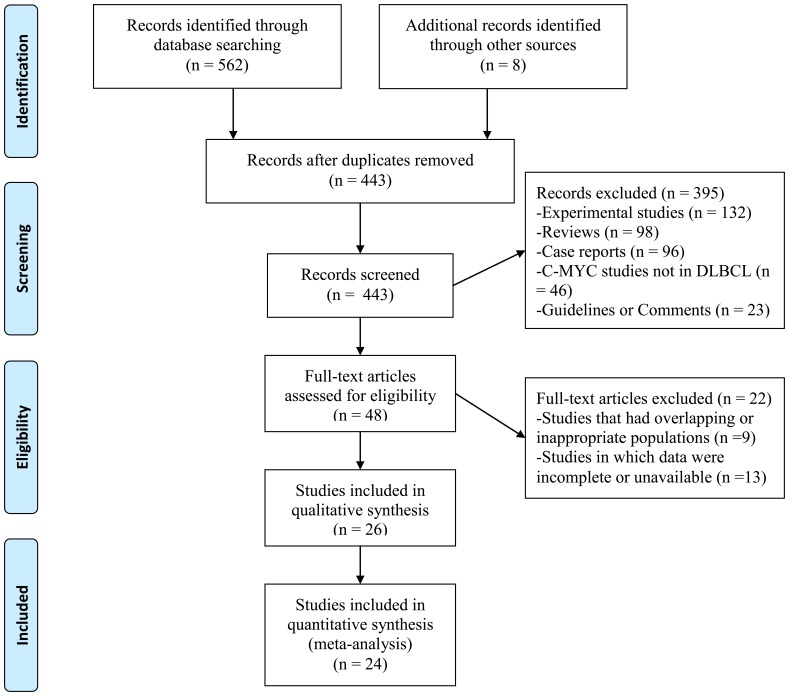
PRISMA flow chart of study selection.